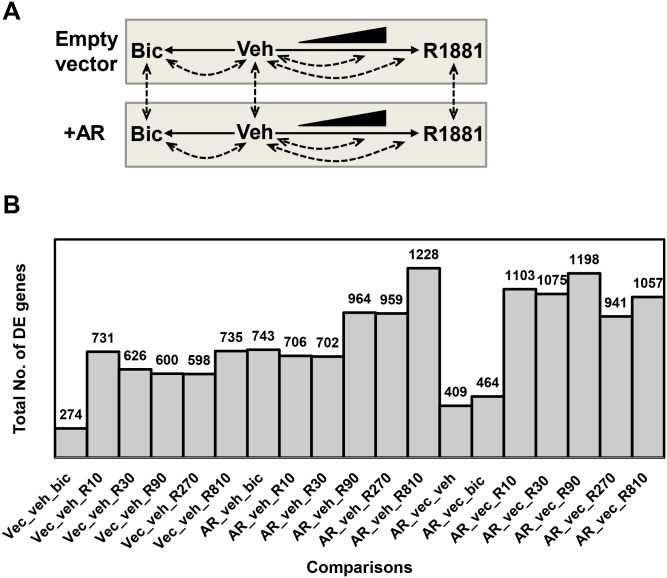
The androgen receptor (AR) as a case-study for Application II.A) Schematic view of the microarray experimental design in AR case study [14] and possible comparisons which can be used to obtain DE genes. B) The number of DE genes achieved by each comparison.